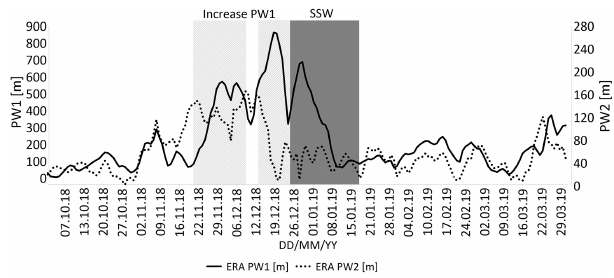
Figure 9. Same as Fig. 3 but October 2018 through March 2019.